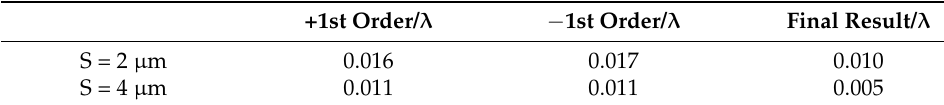
Table 2. The RMS values of test results in Figure 11.